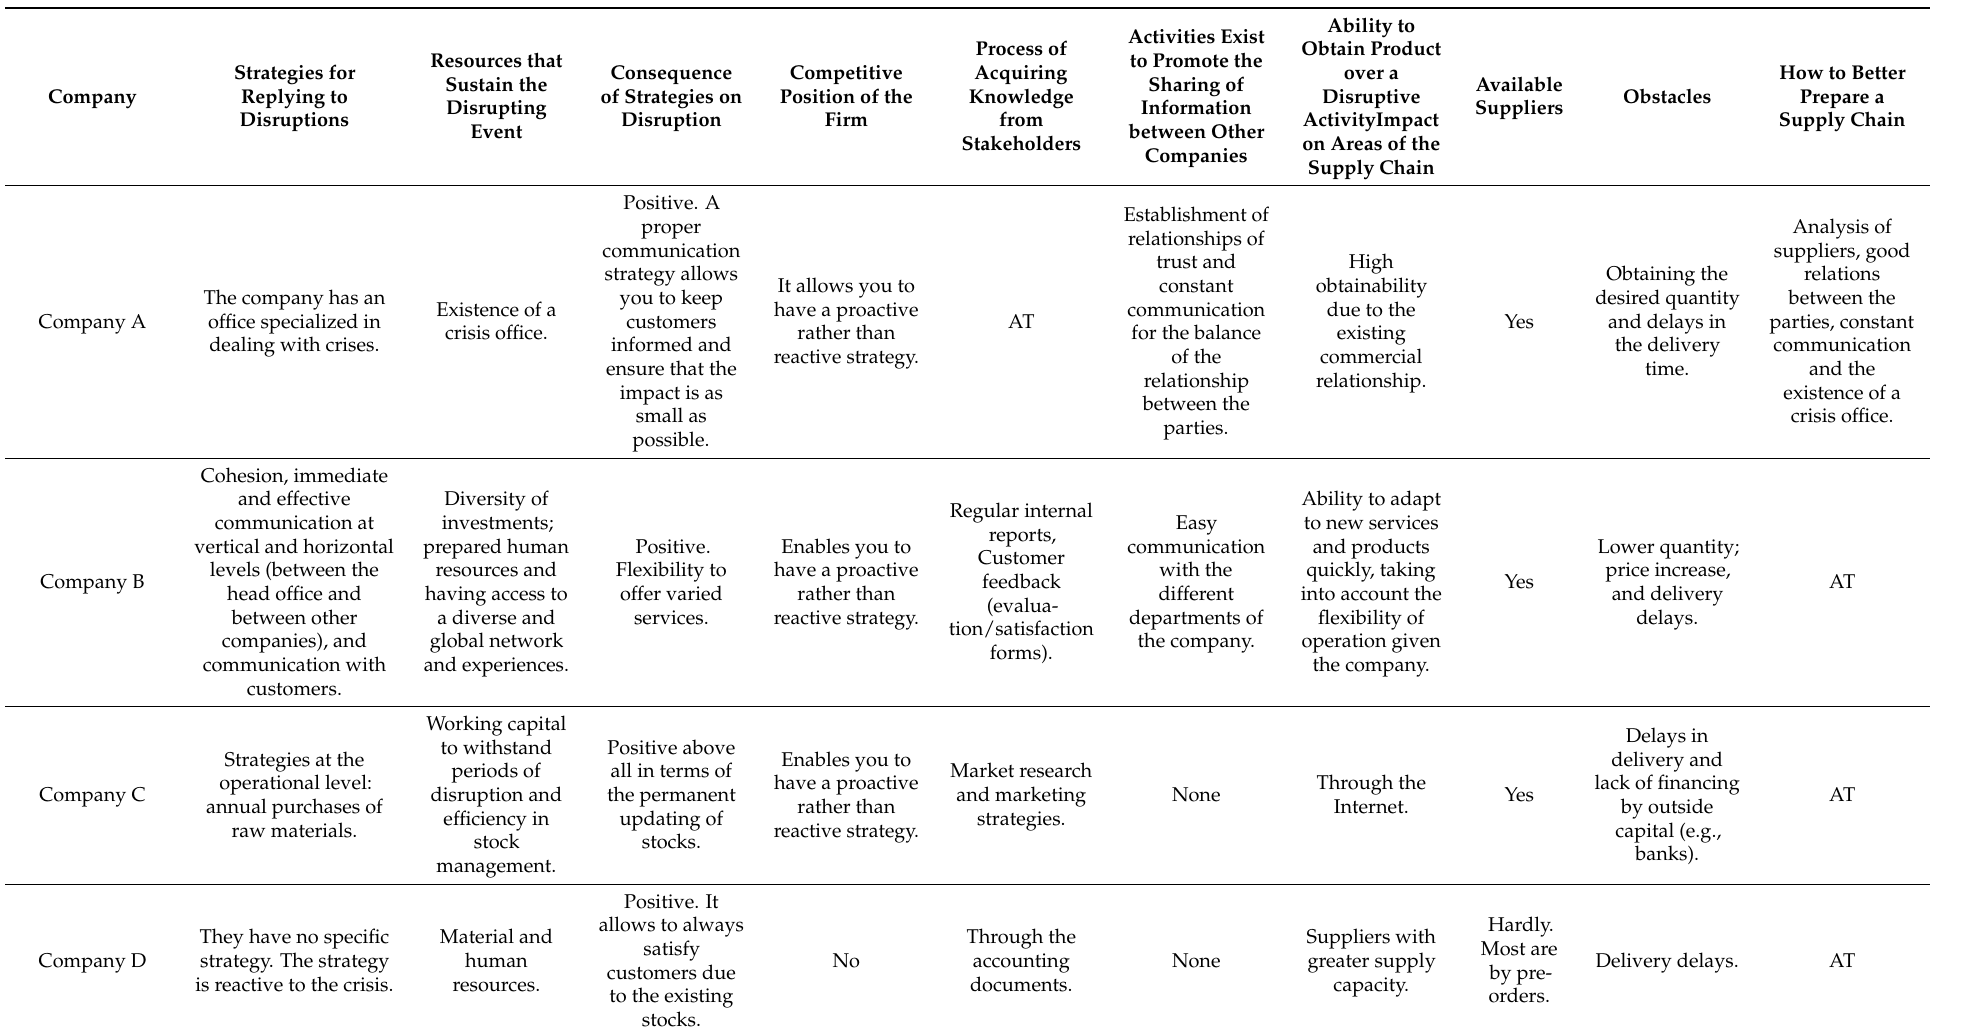
Table 4. Resilience in the Supply